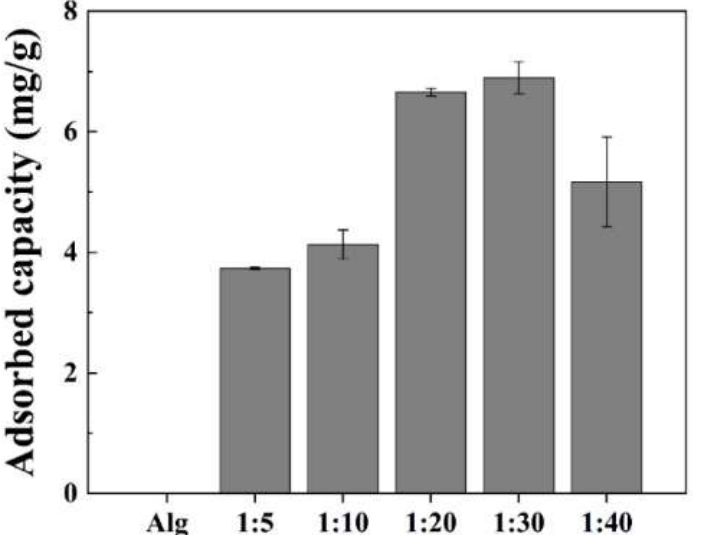
Figure 1. Iodide adsorption capacity of parent alginate (Alg) and beads prepared with different Alg and bismuth oxide (BO) weight ratios (initial iodide concentration: 20 mg/L, initial adsorbent concentration: 1 g/L, and contact time: 24 h).